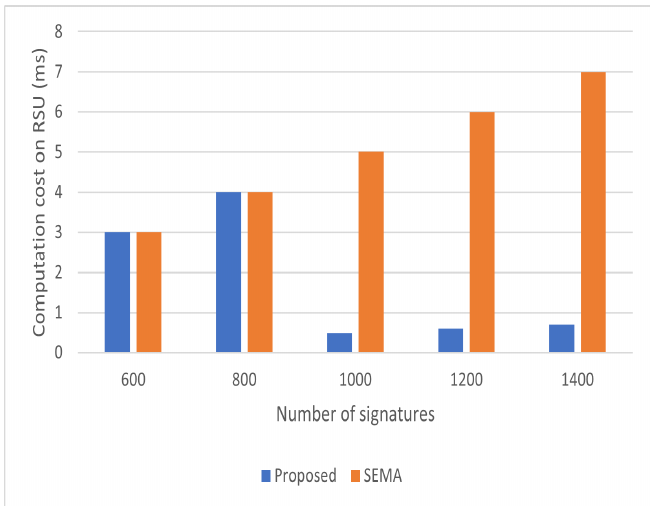
Figure 4. Computation time at the